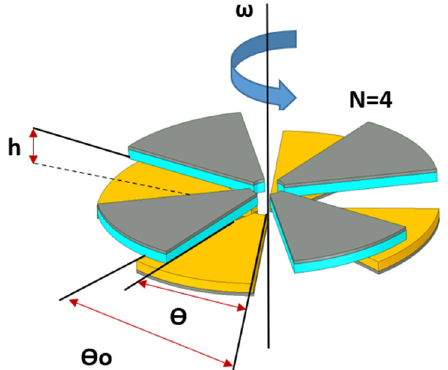
Figure 2. Schematic view of the rotational TENG, where θ 0 and θ represent radians’ sector and rotation angles, respectively. N , h , and ω are the grating number, the gap between triboelectric material, and the rotational speed.